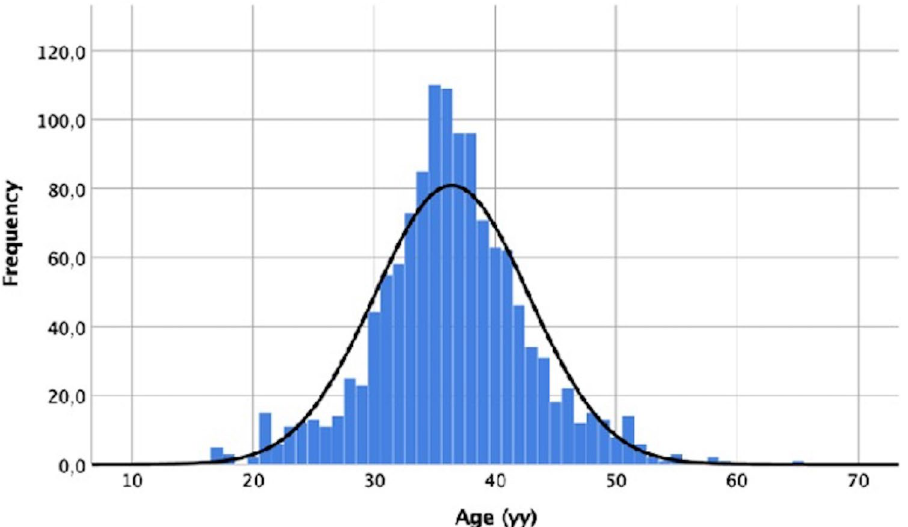
Figure 5. Graphic showing the distribution of age in the analysed sample (min = 16, max = 65; 95% CI